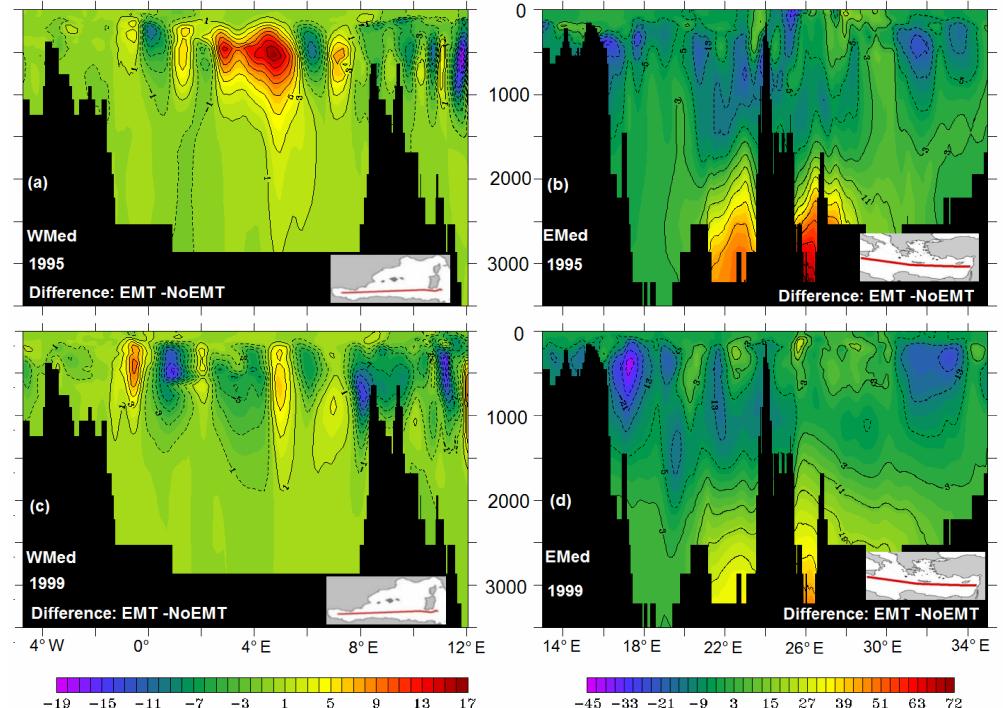
Figure 10. (cid:49) 14 C difference between EMT and NoEMT experiments along sections in the WMed (left column) and in the EMed (right column) for 1995 (top) and 1999